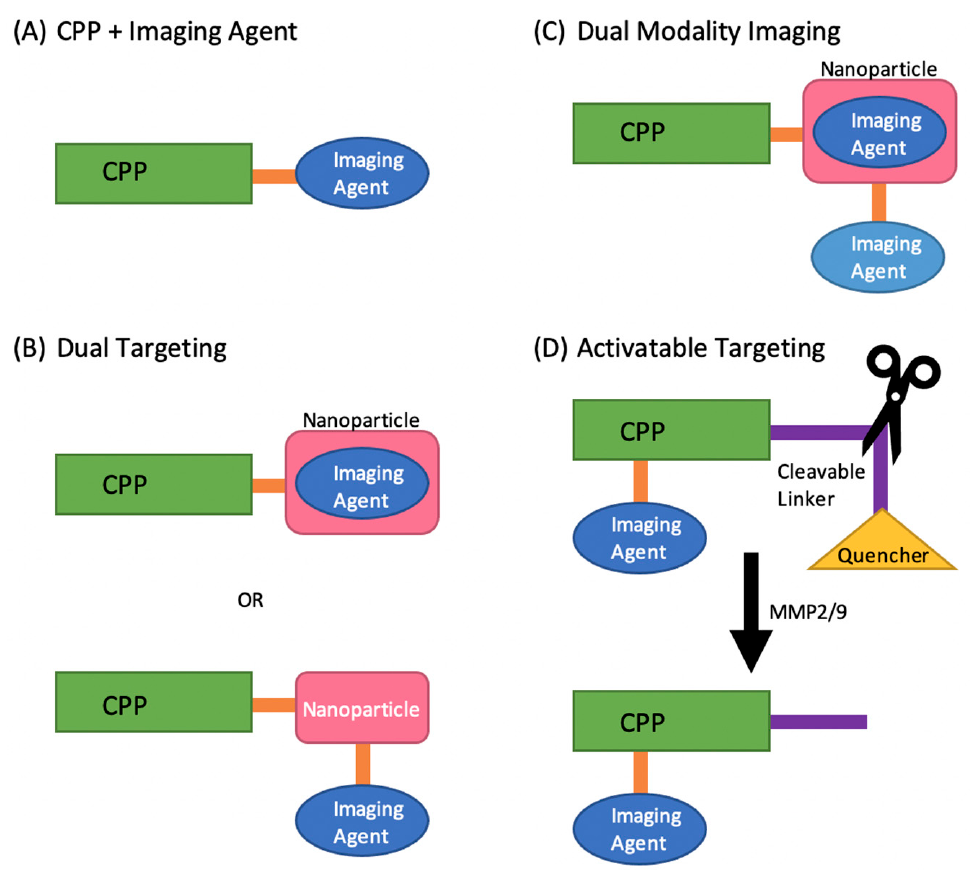
internalization efficiency, and D-enantiomers decrease degradation by proteases, the L- and D-forms of the oligoarginines (2, 8, 12, and 16 mers) were repeated. The results showed the D-isoform of R8 as having the highest accumulation in tumors. This study not only high- lights CPPs as promising agents for tumor imaging, but also demonstrates how changes in peptide amino acid sequence and configuration can affect their physicochemical properties, leading to a CPP better suited to the task of imaging [39].